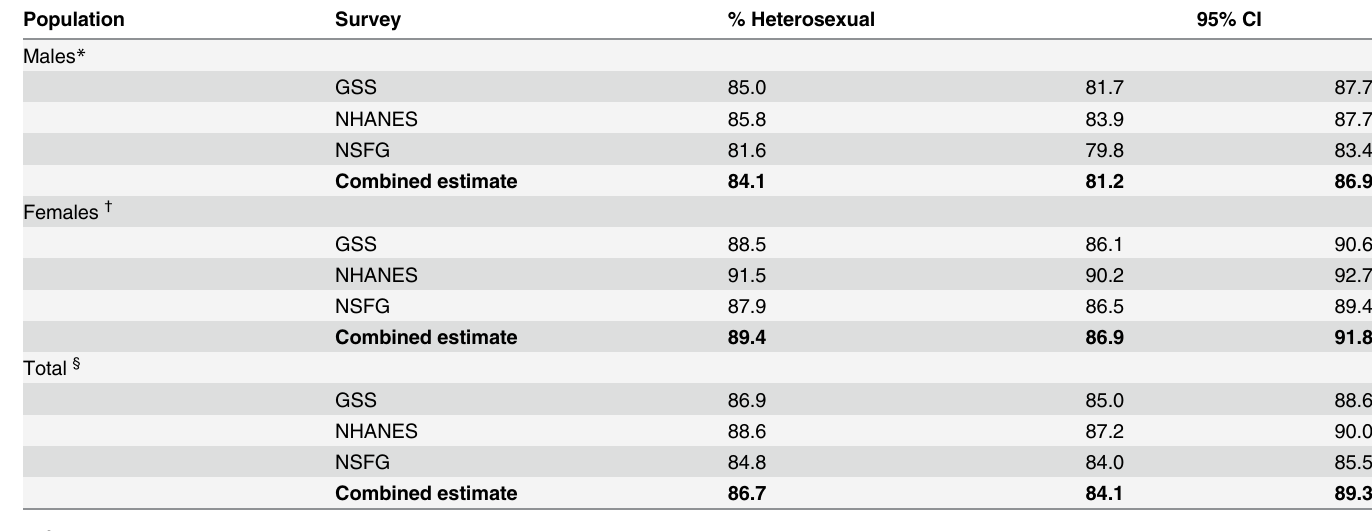
Table 2. Estimated proportion of heterosexual persons in the United States, by survey and combined by meta-analysis. Population